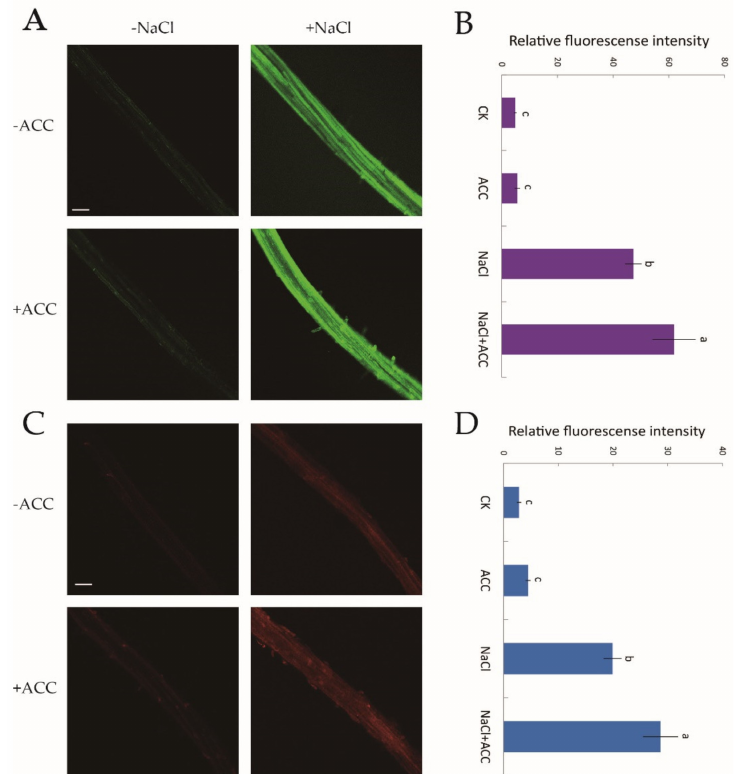
Figure 6. E ff ects of exogenous ACC on cytosolic H 2 O 2 and Ca 2 + accumulation in NaCl-exposed Col-0 root tips. Half of MS-cultured roots were untreated or subjected to a short-term NaCl stress (100 mM, 12 h) in the absence or presence of ACC (10 µ M). Roots were then incubated with two specific fluorescent probes (H 2 DCF-DA, green and Rhod-2 AM, red) for H 2 O 2 and Ca 2 + detection, respectively, for 30 min. ( A , C ) Confocal images of H 2 O 2 and Ca 2 + fluorescence within root cells (scale bars, 250 µ m); ( B , D ) the relative green and red fluorescence intensity at the maturation root zones (1000 µ m from the root apex) with or without the application of ACC in salt-treated roots. Each column ( ± SD) represents the mean of five to six individual plants and the letters a, b, and c denote significant di ff erences between di ff erent treatments ( p <